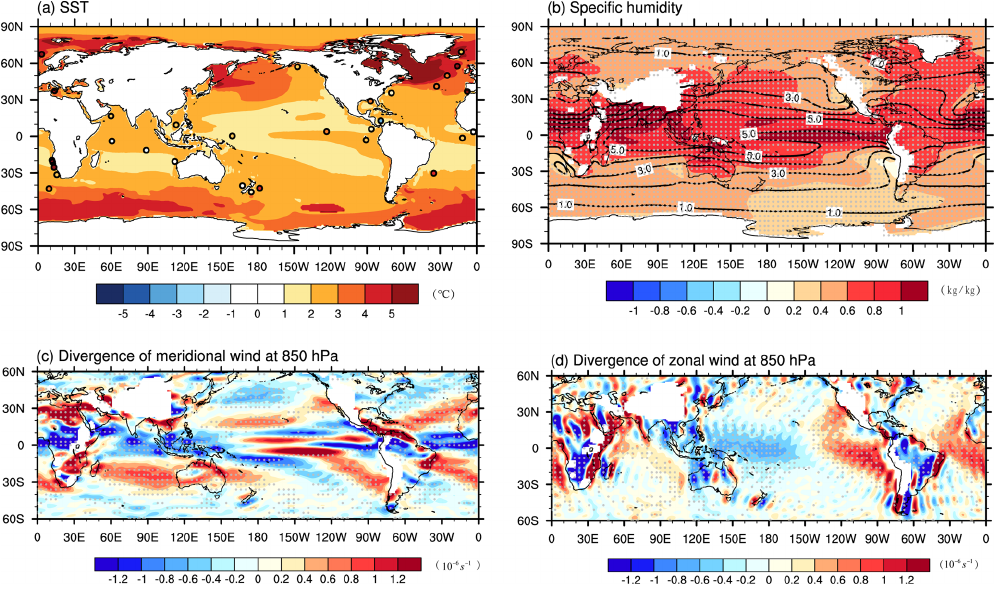
Figure 7. Change in (a) MMM SST (shading; in ◦ C), and (b) specific humidity (shading; in kgkg − 1 ) overlaid by its climate mean for the PI simulation. Panels (c) and (d) show the MMM divergence of the meridional V M and zonal wind V Z fields decomposed from the 3P-DGAC method at the 850hPa level for the PI simulation (in 10 − 6 s − 1 ). The circles in panel (a) are the anomalies of reconstructed SST (cid:48) (McClymont et al., 2020) from the alkenone-derived U K index (Prahl and Wakeham, 1987) and foraminifera calcite Mg / Ca (Delaney et 37 al., 1985). Stippling in panels (b–d) indicates regions where at least 10 of 13 simulations in the model group agree on the sign of the ensemble